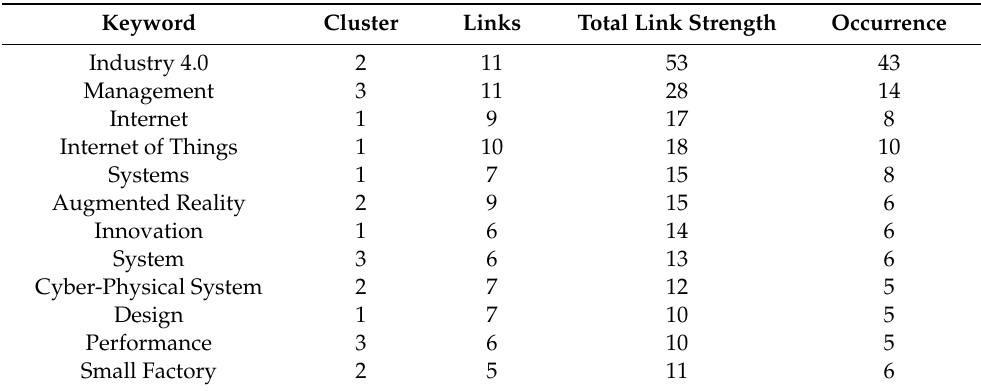
Table 5. Most common co-occurring keywords of “Industry 4.0” OR “Industrial revolution 4.0” AND TOPIC “construction” OR “building” in Web of